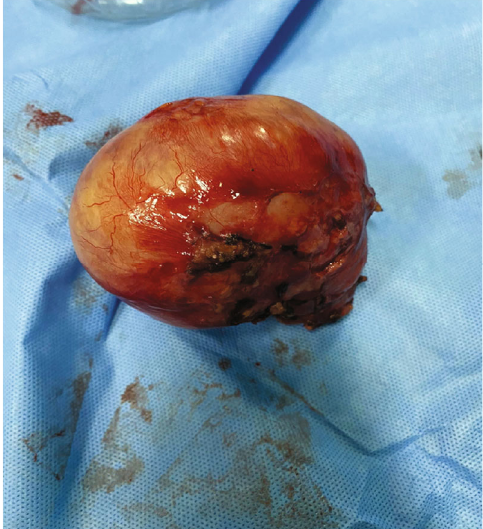
Figure 4: Operative specimen showing abdominopelvic